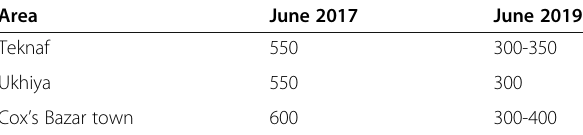
Table 2 Change in the average rate of daily labour (in BDT) (following the arrival of the Rohingya